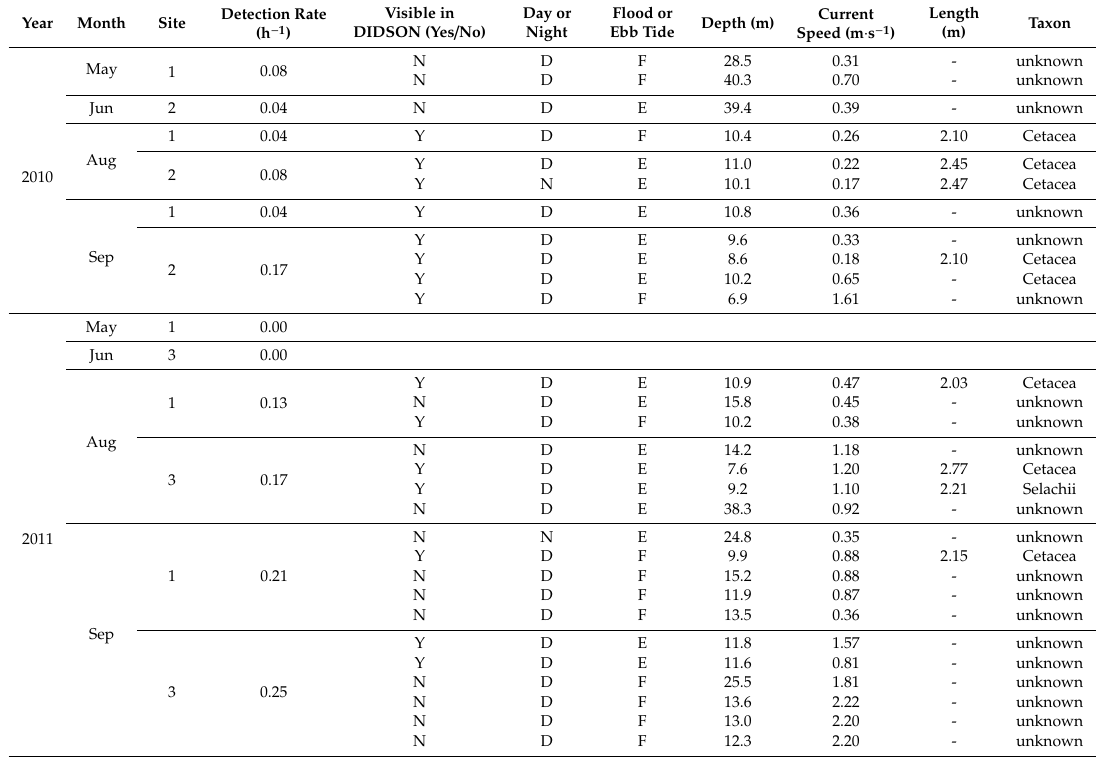
Table 2. All detections of strong acoustic targets with TS greater than − 30 dB re 1 m 2 and less than 1 m in height in the Simrad data. When a valid length measurement was not possible, a dash was entered. Each survey month represents a single 24-h